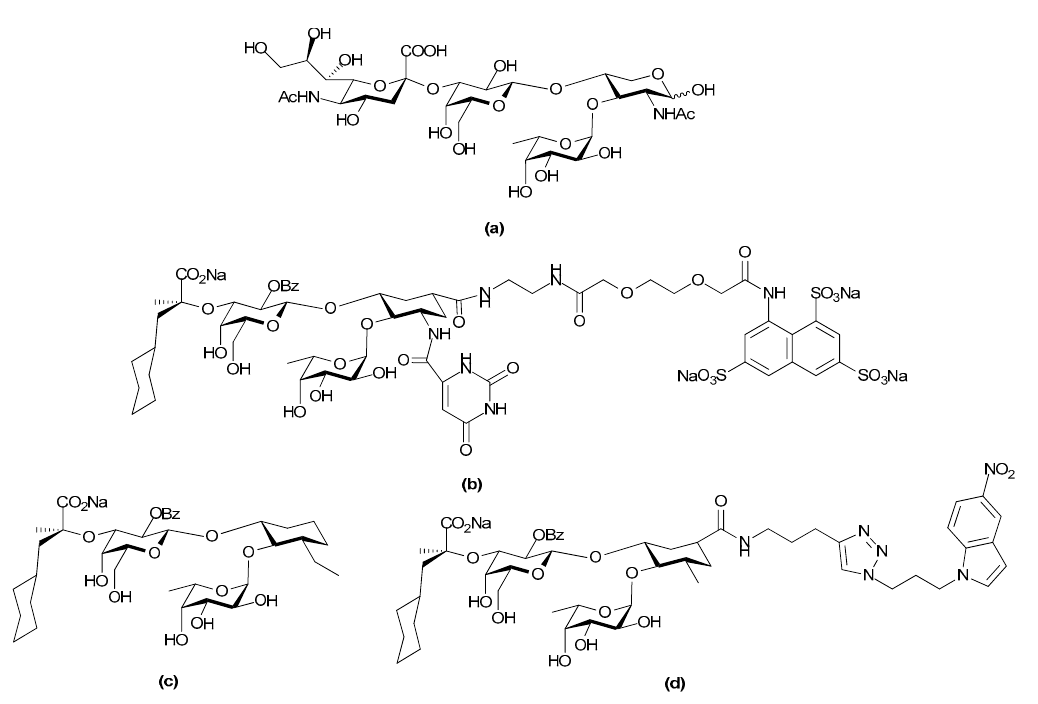
Figure 9. Chemical structure of ( a ) Sialyl Lewis x (sLe x ); ( b ) GM-1070, sLe x mimic in clinical trials for treatment of vaso-occlusive crisis in sickle cell disease patients; ( c ) sLe x mimic that maximizes conformational pre-organization of the binding determinants; ( d ) sLe x mimic designed using fragment based discovery techniques with improved binding kinetics.